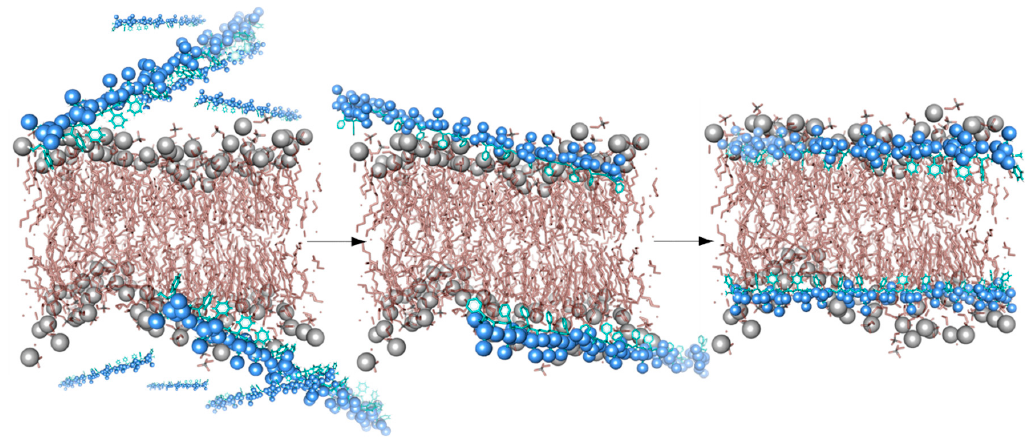
Figure 1. A schematic model showing interactions between SMA polymers (blue) and a membrane bilayer (grey).